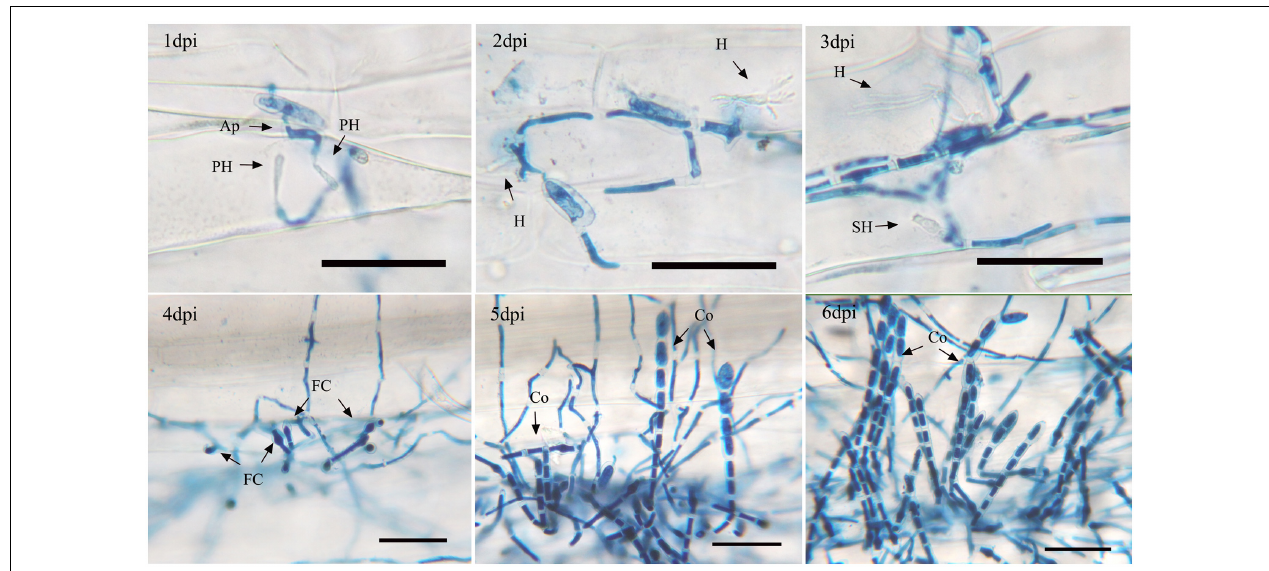
FIGURE 1 | Asexual life cycle of Bgt . Infected leaf segments of Chancellor by isolate 21-2 were sampled at 1, 2, 3, 4, 5, and 6 day post inoculation (dpi) and trypan blue staining was performed. Ap, appressorium; PH, primary haustorium; H, the first mature haustorium; SH, secondary haustorium; M, mycelium; FC, foot cell; Co, conidiophore. The bars represent 50 µ m.